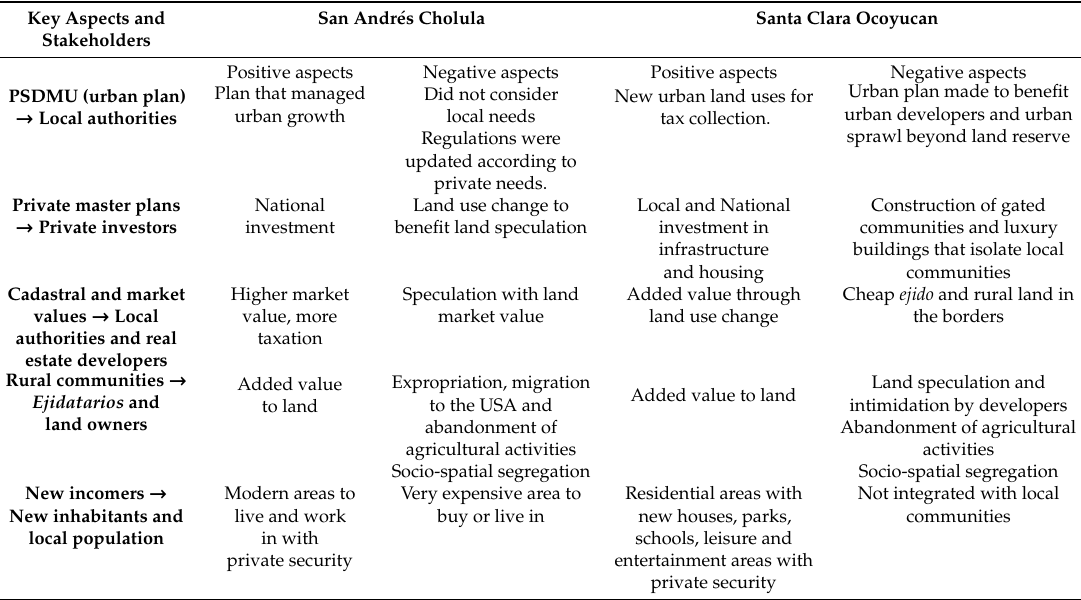
Table 5. Positive and negative aspects of the urbanization of Ejidos in the case study areas. Source: Melissa Schumacher